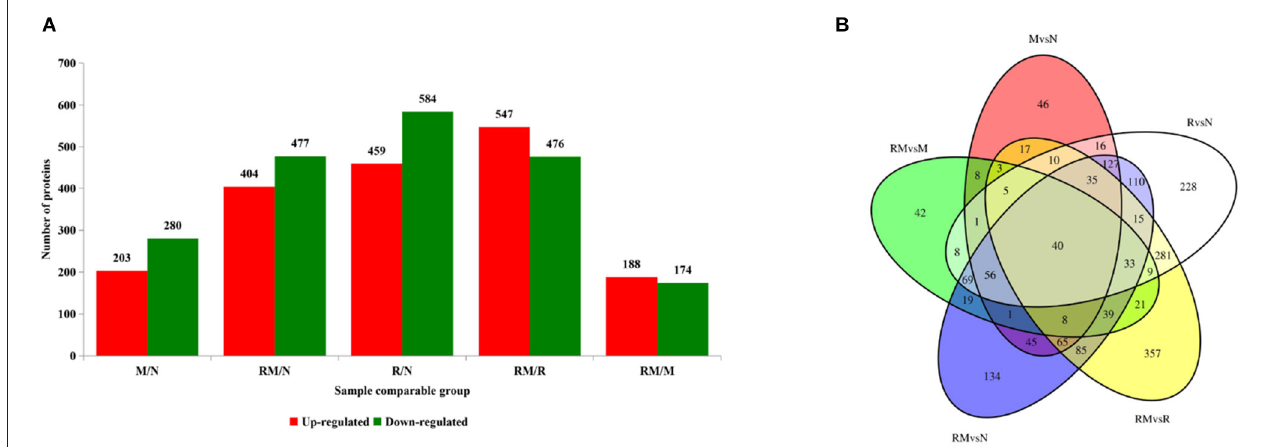
FIGURE 3 | Distribution of differentially accumulated proteins (DAPs). (A) Number of upregulated (red) and downregulated (green) DAPs in M vs. N, R vs. N, RM vs. N, RM vs. M, and RM vs. R. (B) Venn diagram to show the distribution of DAPs between RM vs. N (blue circle), RM vs. R (yellow circle), RM vs. M (green circle), R vs. N (white circle), and M vs. N (red circle). N, mock-infected CEF cells; R, REV-infected CEF cells; M, MDV-infected CEF cells; RM, REV and MDV coinfected CEF cells. CEF, chicken embryo fibroblast; REV, reticuloendotheliosis virus; MDV, Marek’s disease